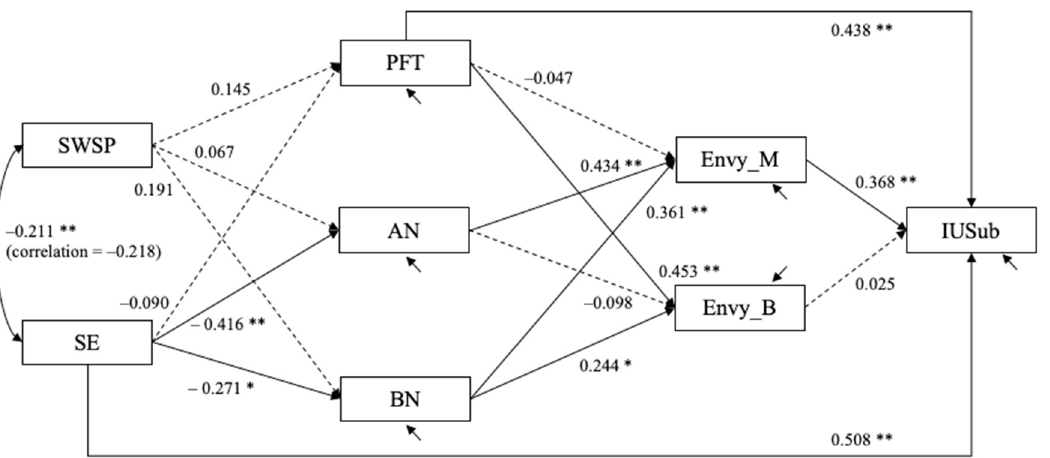
Figure 7. Study 2: Estimated structural equation model with subjective measure of Instagram usage (N = 140).